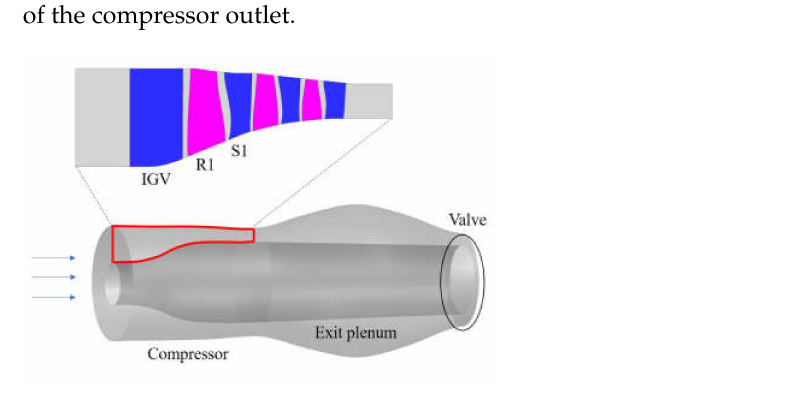
Figure 12. The unified compression system. (IGV: Inlet guide vane, R1: Rotor 1, S1: Stator 1).